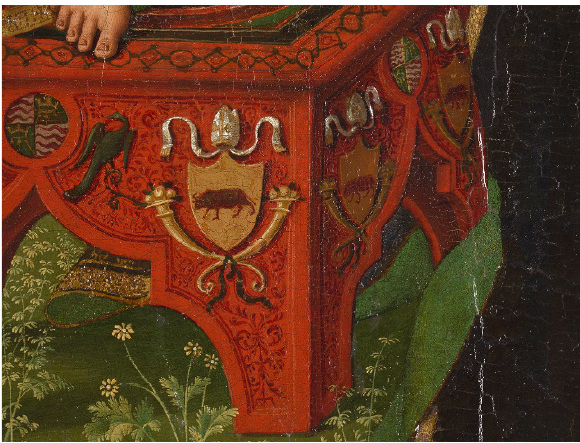
Figure 16 . Detail of the birds and the botanical elements.